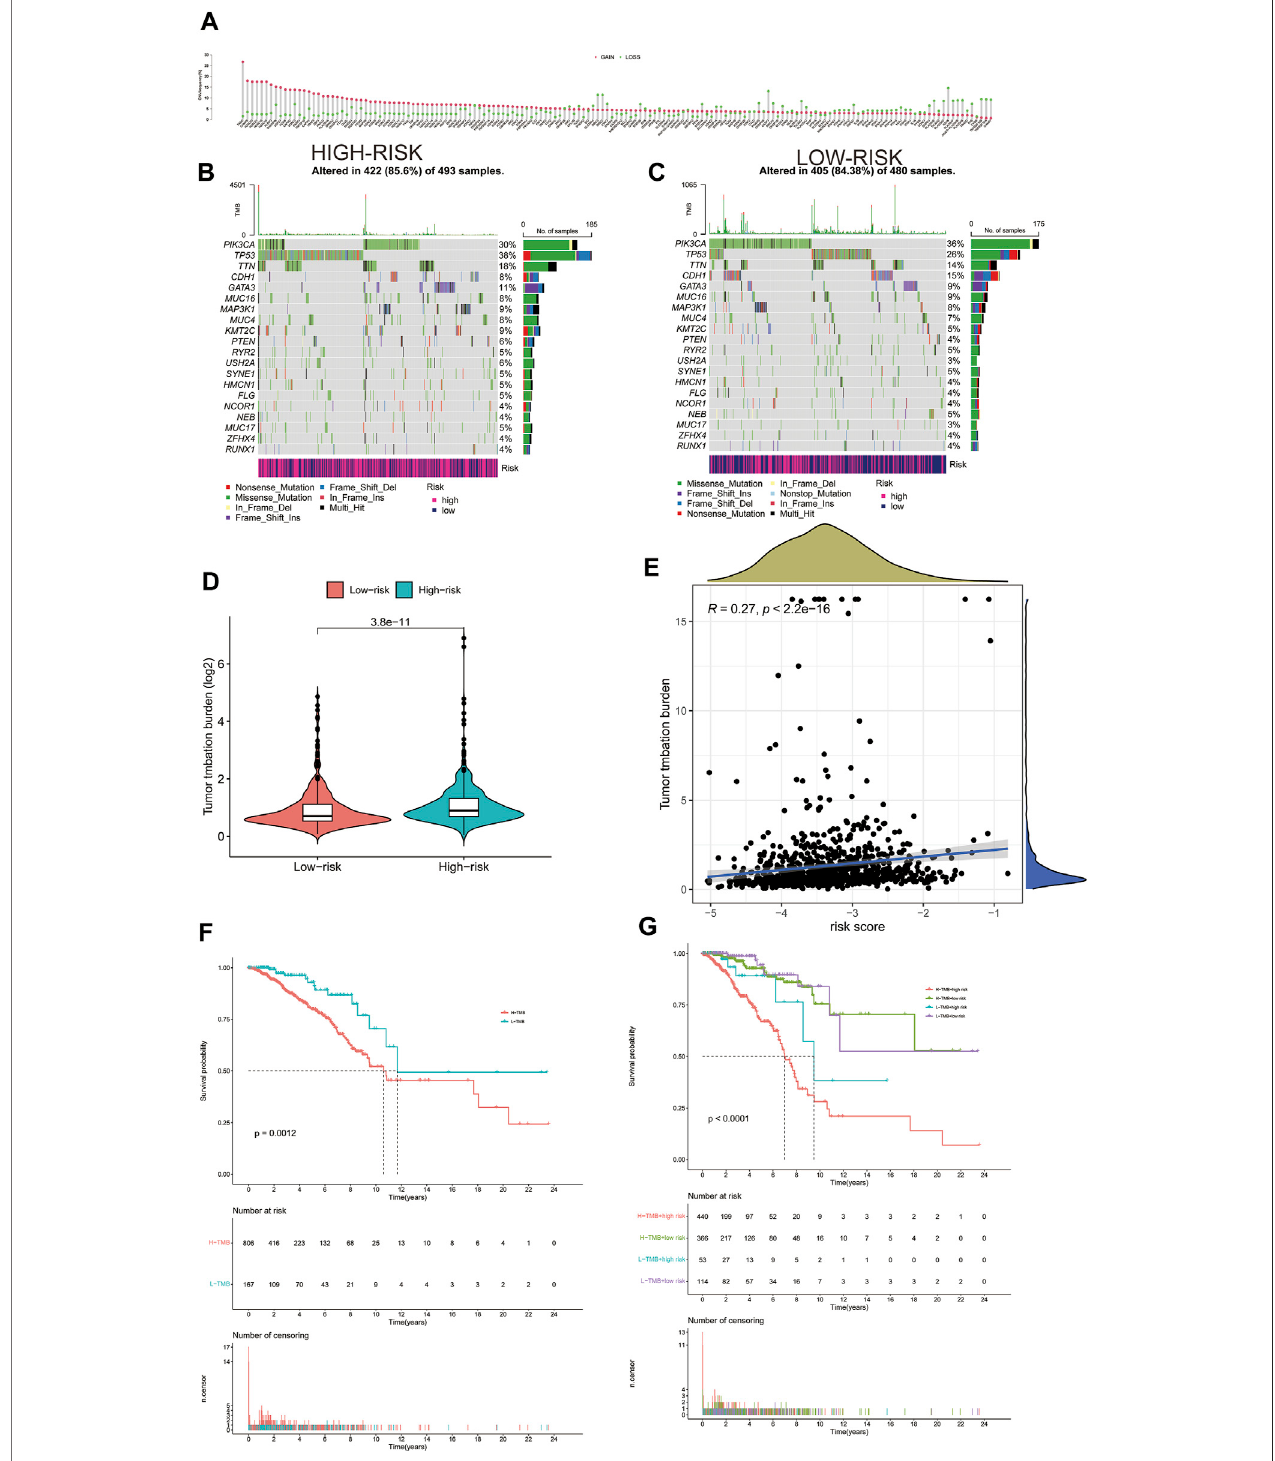
FIGURE7| Gainandlossofalldifferentialgenes (A) .Waterfallplotofeachmutationinthehigh-riskgroupinTCGA (B) .Waterfallplotofeachmutationinthelow-risk group in TCGA (C) . The difference of Tumor Mutation Burden between high-risk and low-risk groups (D) . Correlation between tumor mutation load and risk score (E) . Kaplan – MeiercurvesofOSbetweenhighandlowtumormutationload (F) .Kaplan – MeiercurvesofOSbetweenhighandlowtumormutationloadandhigh-andlow-risk groups (G) .